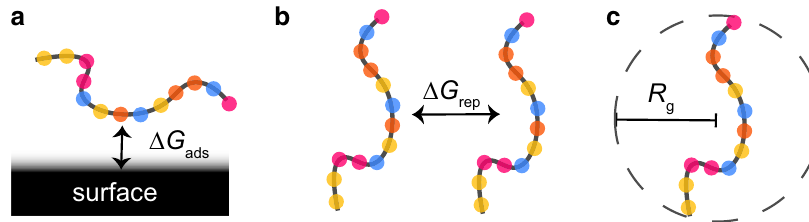
Fig. 2 Schematic illustration of the polymer performance descriptors that we calculate using coarse-grained simulations. a Δ G ads is the single-molecule free energy of adsorption onto a model surface. b Δ G rep is the dimer repulsion energy. c R g is the radius of gyration, an indicator of polymer viscosity.